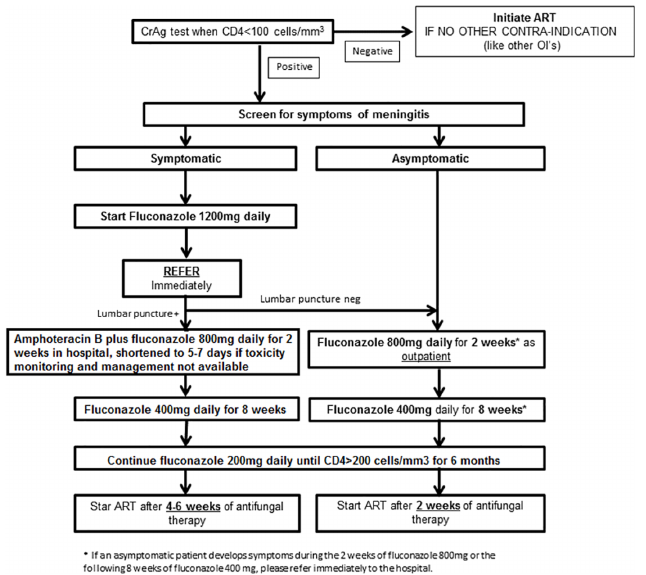
Fig 1. Algorithm for screening and pre-emptive treatment of cryptococcal meningitis.